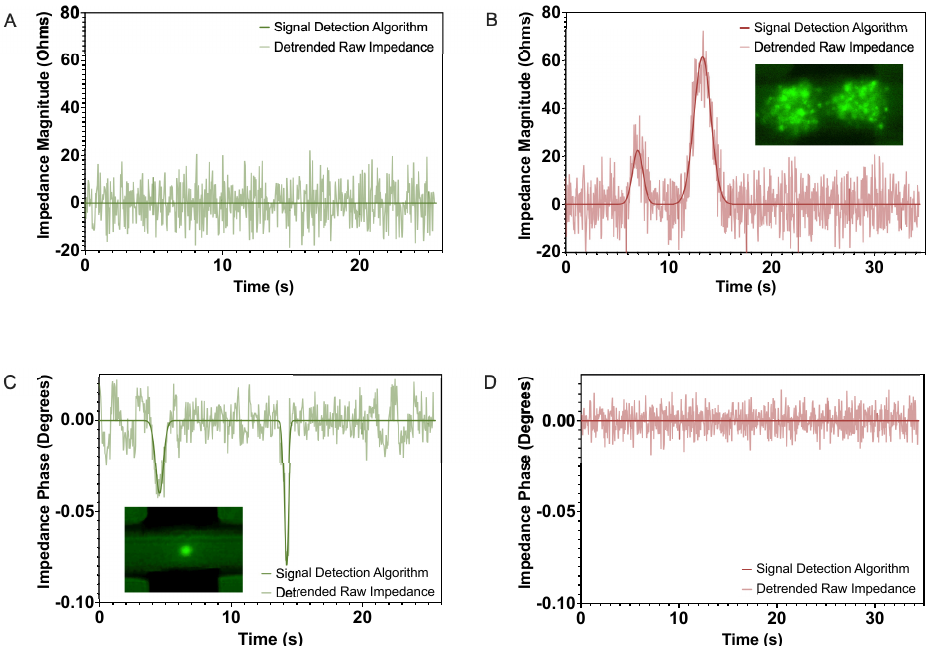
Figure 6. Relative changes in ( A ) impedance magnitude of live cells, ( B ) impedance magnitude of dead cells, ( C ) impedance phase of live cells, and ( D ) impedance phase of dead cells. Raw and filtered data are shown for each dataset. Stills from fluorescence video microscopy corresponding to dead and live cell detection events are shown in the corresponding windows.